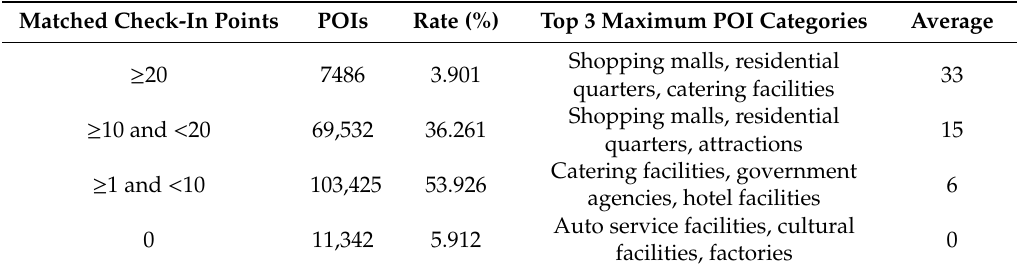
Table 1. Overall similarity matching